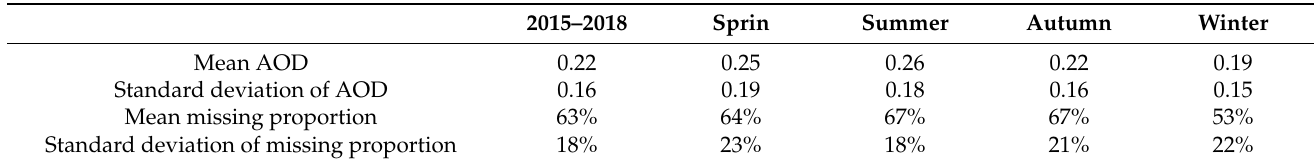
Table 1. Mean and seasonal means of aerosol optical depth (AOD) and its missing proportion for 2015–2018 in main- land China.